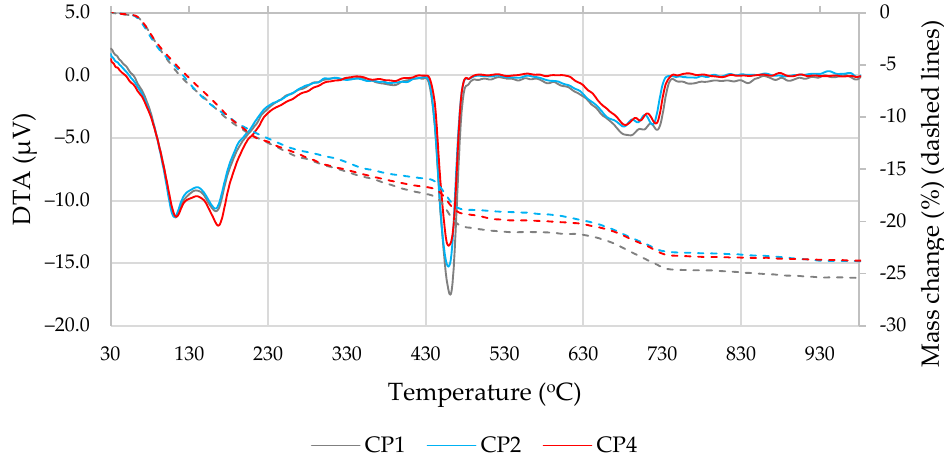
Figure 9. DTA and TG results after 7 days of curing.